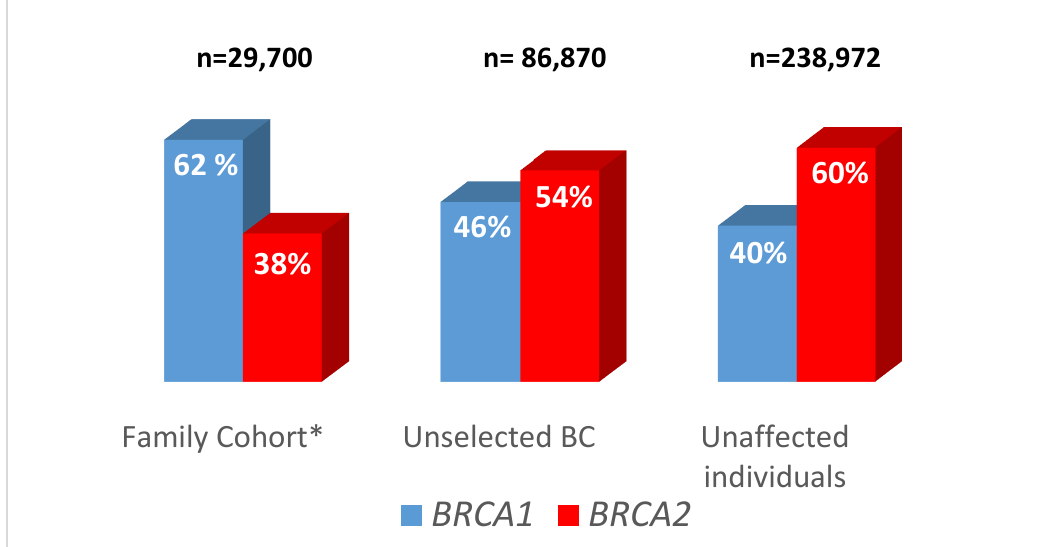
Figure 4. gBRCA1 and gBRCA2 frequency among family cohorts, unselected breast cancer patients and unaffected individuals. * Family cohort: 29,700 gBRCA families from the CIMBA cohort (6).